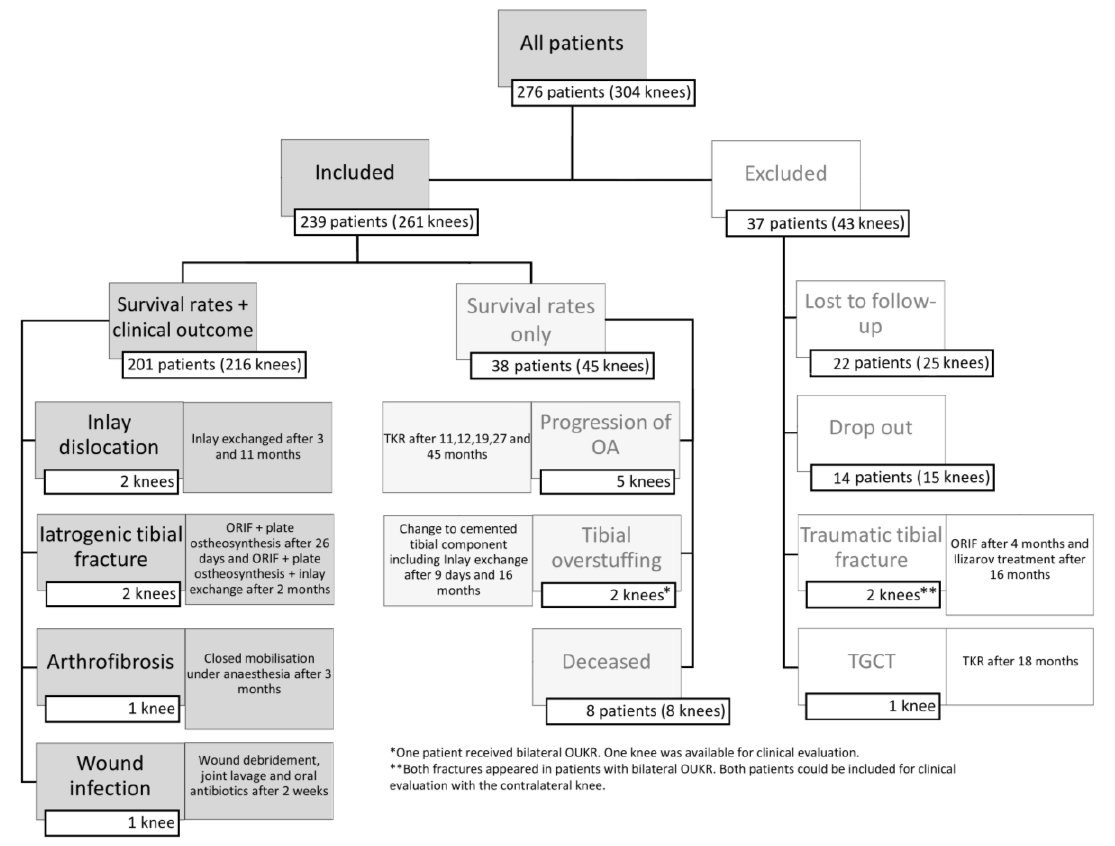
Figure 1. Overview — patient cohort. Figure 1. Overview—patient